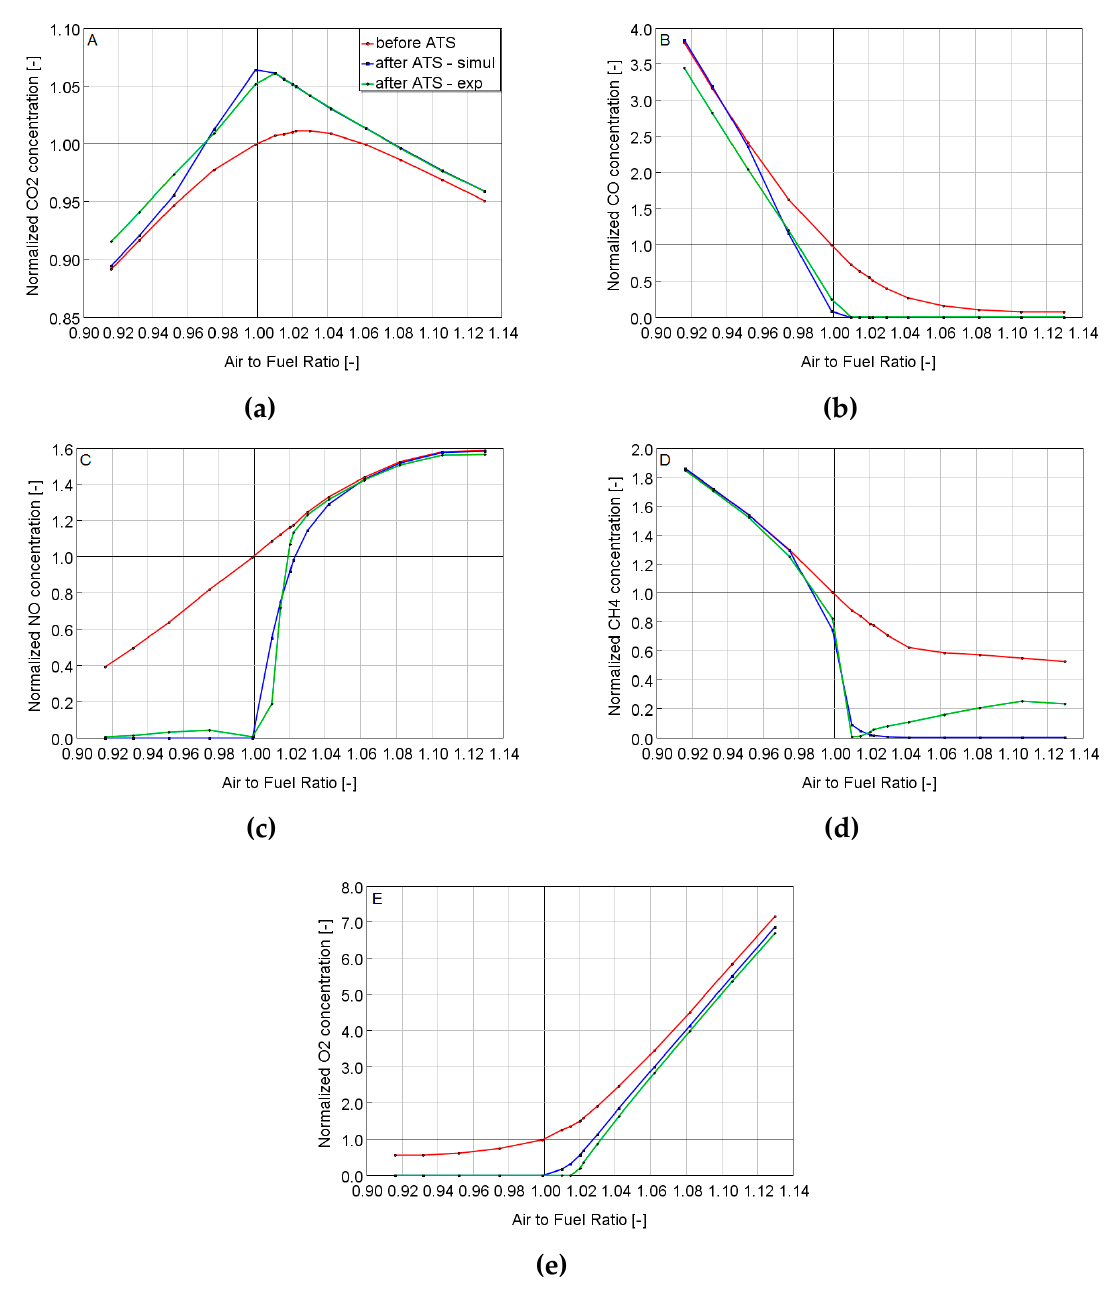
Figure 7. SS tests at 80% Load. Gas Temp. ≈ 750 ◦ C. (1900 RPM, 80% load). ( a ) Num / Exp. CO 2 engine out and tailpipe concentration. ( b ) Num / Exp. CO engine out and tailpipe concentration. ( c ) Num / Exp. NO engine out and tailpipe concentration ( d ) Num / Exp. CH 4 engine out and tailpipe concentration. ( e ) Num / Exp. O 2 engine out and tailpipe concentration.